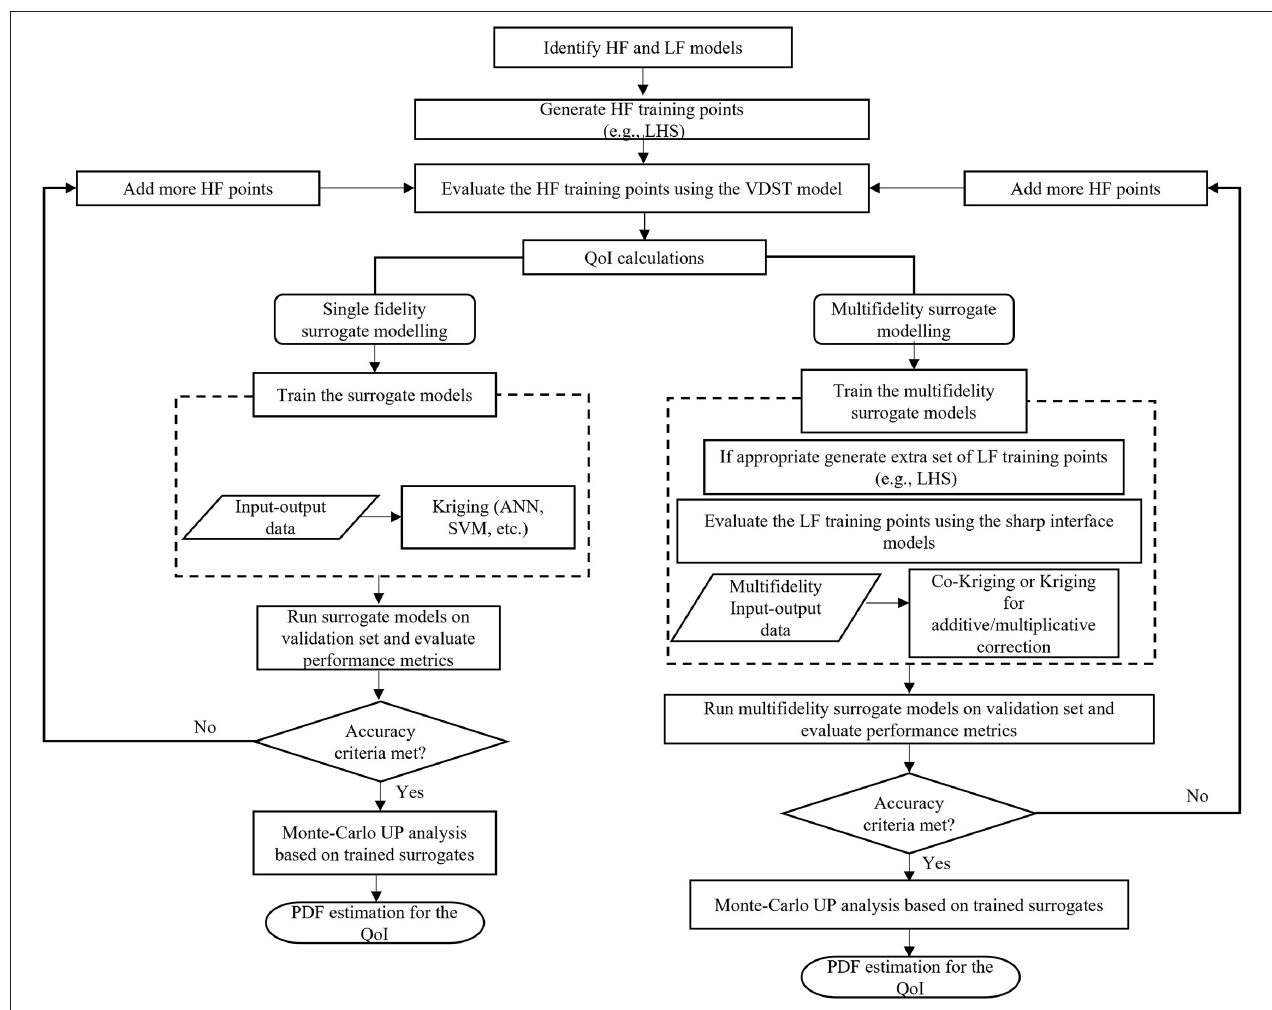
FIGURE 3 | Workflow for the Monte-Carlo UP analysis based on the surrogate